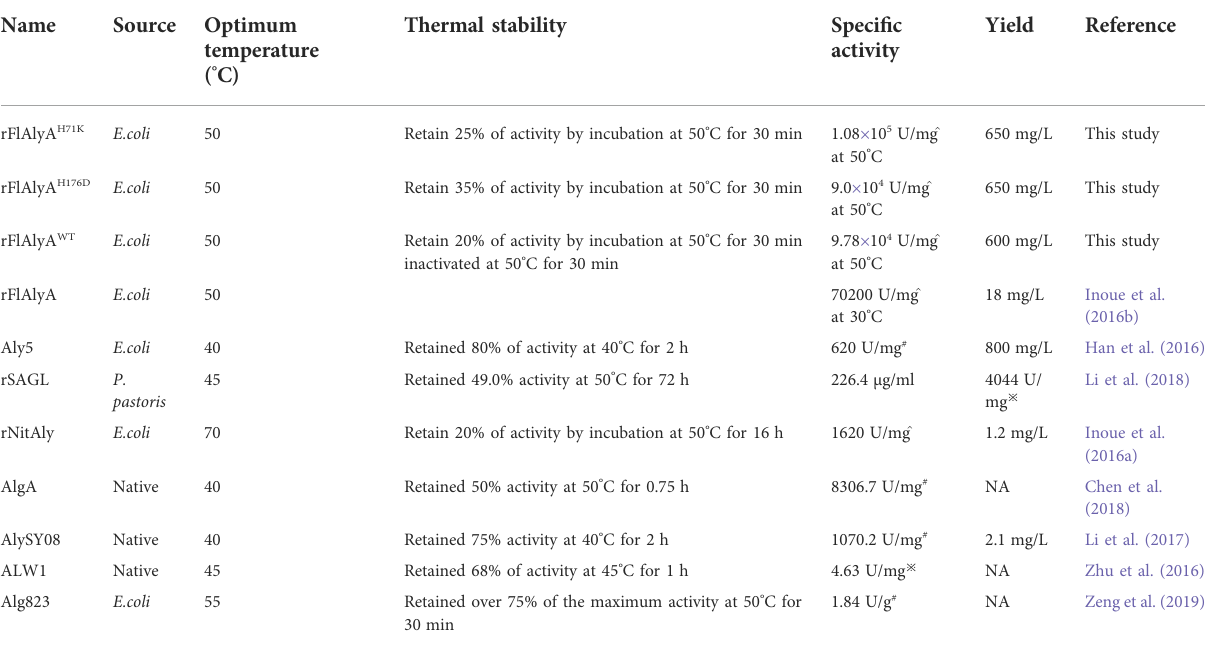
TABLE 2 Catalytic property comparisons of some alginate lyases.